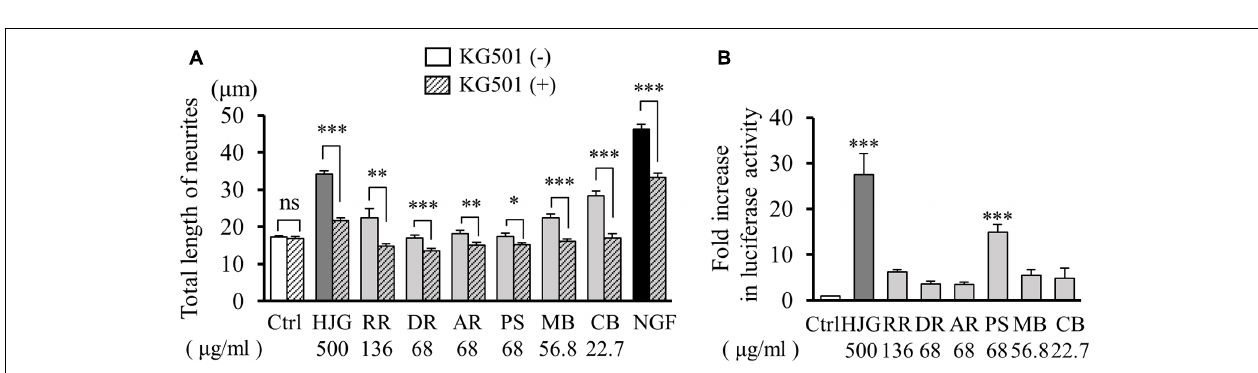
FIGURE 3 | Effect of HJG on CREB activation in PC12 cells. (A) HJG induces CREB phosphorylation in a time-dependent manner. PC12 cells were untreated (0 min) or treated with 0.5 mg/ml HJG for 20–120 min. (B) KG-501 inhibited HJG-induced neurite outgrowth of PC12 cells. PC12 cells were pretreated with KG-501 (10 µ M) for 30 min and incubated for 3 days in media containing HJG (0.5 mg/ml) or NGF (50 ng/ml) before assessing the total length of neurites. Data represent mean ± SEM from three independent experiments. ∗∗∗ p < 0.001 indicates significant differences compared with untreated controls (ANOVA followed by Tukey’s test). ††† p < 0.001 indicates significant difference compared with KG-501 + HJG-treated cells and HJG-treated cells (Student’s t -test). ### p < 0.001 indicates significant difference compared with KG-501 + NGF-treated cells and NGF-treated cells (Student’s t -test). (C) PC12 cells were transfected with a CRE-mediated luciferase reporter construct and Renilla luciferase control plasmid for 48 h, and cells were subsequently untreated (Ctrl) or treated with 0.1, 0.2, 0.5, or 1.0 mg/ml HJG for 8 h. Luciferase activities were measured in lysates of transfectants and normalized to their Renilla luciferase control activity. Data represent mean ± SEM from three independent experiments. ∗∗ p < 0.01 and ∗∗∗ p < 0.001 represent significant differences compared with controls (ANOVA followed by Dunnett’s test).